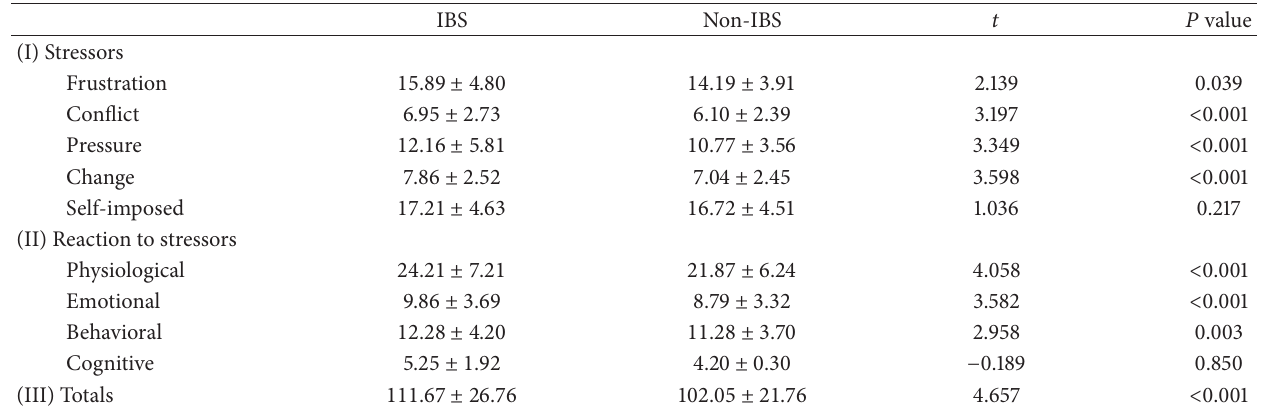
Table 6: The SLSI scores between IBS and non-IBS in